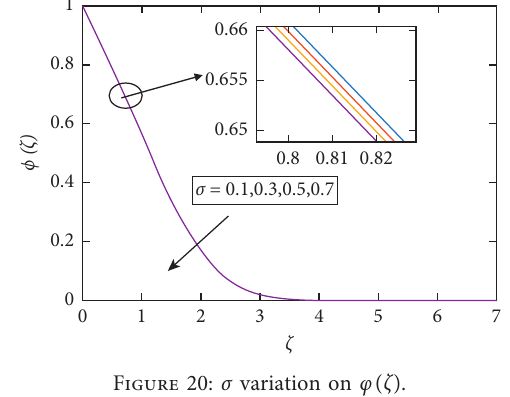
Figure 17: Nt variation on φ ( ζ ) .